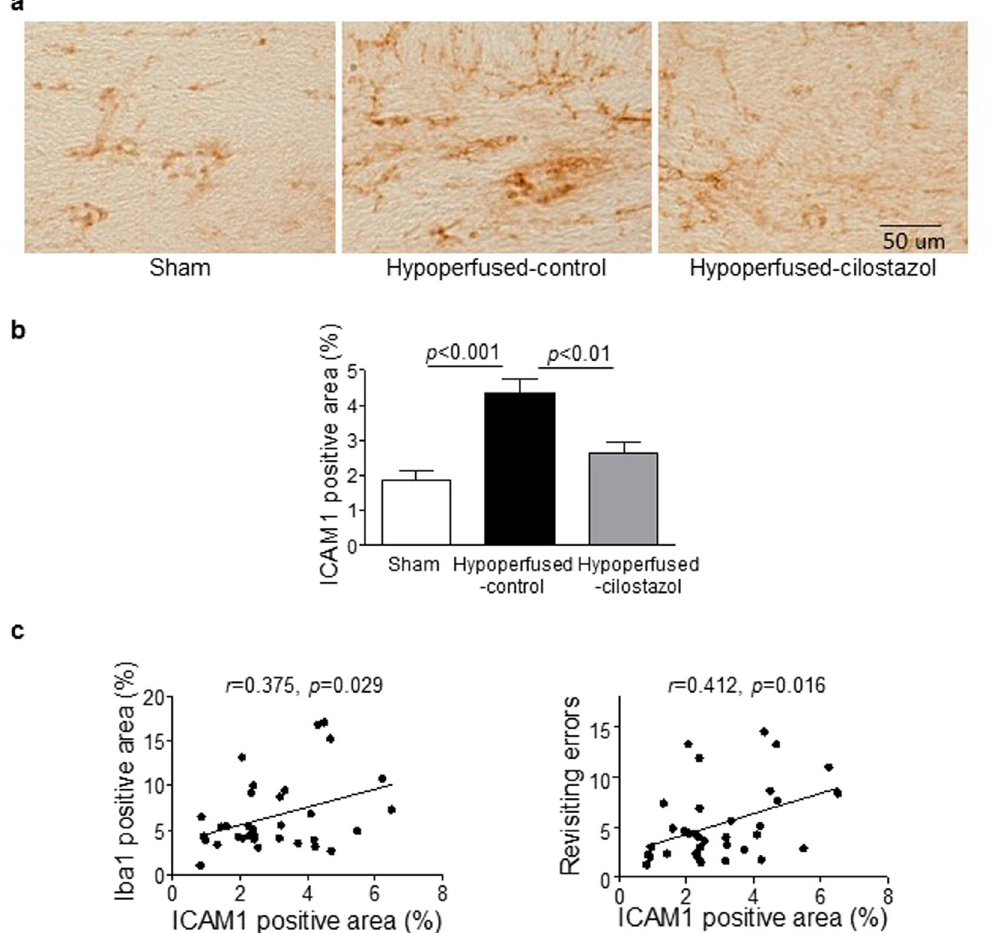
Figure 4. Cilostazol significantly suppressed endothelial adhesion molecule expression in the corpus callosum. ( a ) Representative images of intercellular adhesion molecule-1 (ICAM1) staining in the corpus callosum. ( b ) There was a significant difference in ICAM staining between the three groups ( F (2, 33) = 13.19; p < 0.0001). ICAM1 immunostaining was significantly greater in the hypoperfused-control group compared to the sham ( p < 0.001) and this was reduced with cilostazol treatment ( p < 0.01). ( c ) There was a significant association between ICAM1 positive areas and microgliosis (Pearson r = 0.375, p < 0.05), and the number of revisiting errors (Pearson r = 0.412, p < 0.05). Data represents mean ±